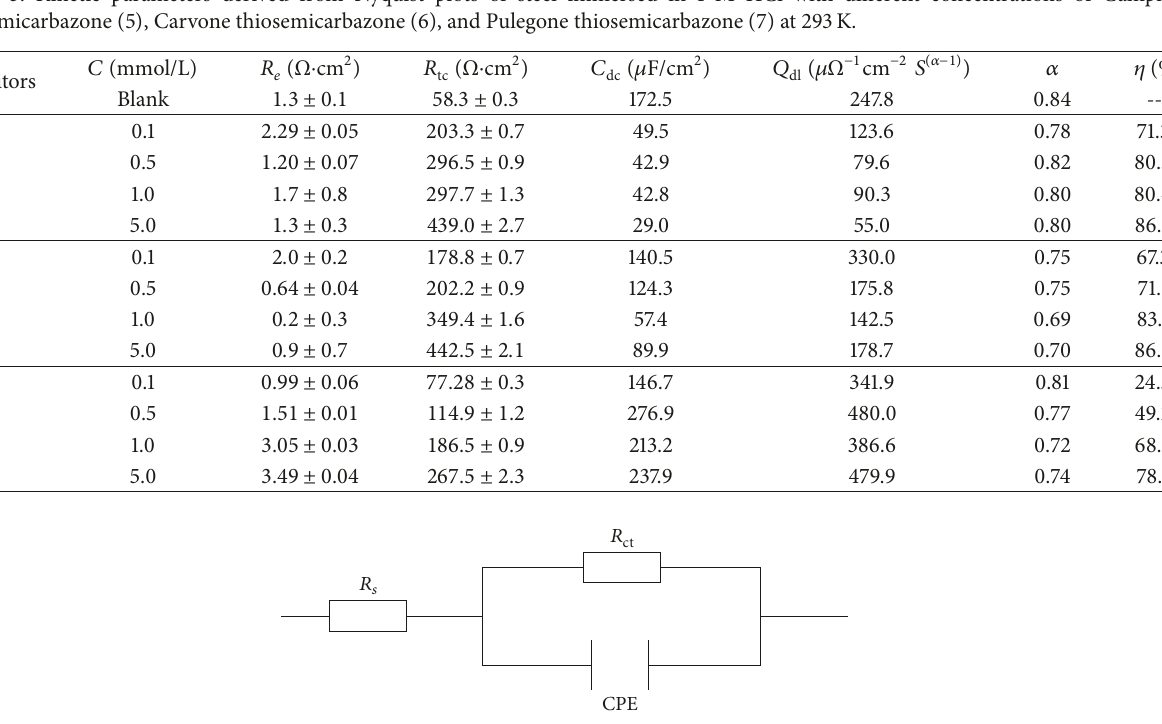
Figure 4: Equivalent electrical circuit of the interface of steel/HCl